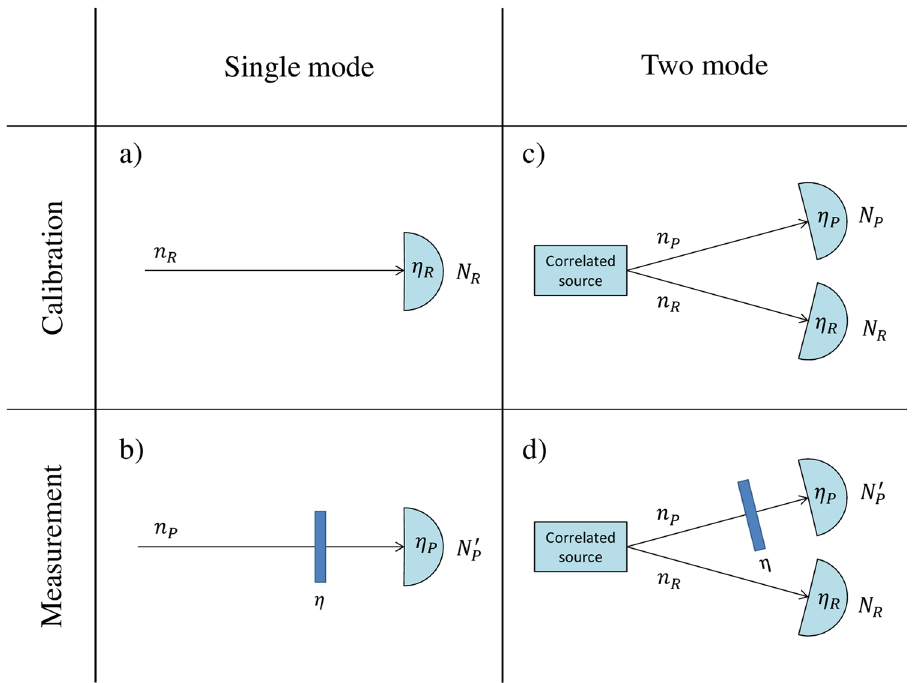
Figure 1. Two possible schemes to estimate the absorption coefficient α . In the single-mode case ( a ) and ( b ) there is no correlation between probe and reference beam, i.e. 〈 Δ N p Δ N R 〉 = 0 while in the two-mode case ( c ) and ( d ) 〈 Δ N p Δ N R 〉 ≠ 0. Different possibilities of input states and absorption estimators for both the schemes are discussed in the